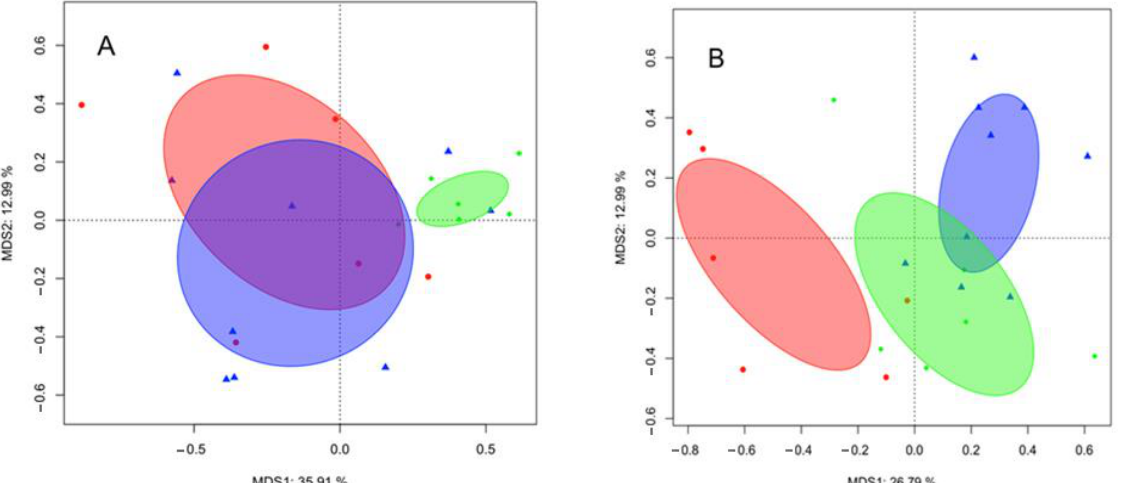
Figure 2. Results of Principal Co-ordinate Analysis (PCoA) of the contemporary and subfossil Cladocera assemblages of the three sampling sites of the Nagy–Morotva oxbow lake. ( A ) Contemporary Cladocera assemblage, ( B ) Subfossil Cladocera assemblage. The group centroids of the sites are marked with coloured ellipses (Red: Fishing site-1, Blue: Natural site, Green: Fishing site-2). Table 3. Result of pairwise multilevel comparison of subfossil Cladoceran assemblages in the three sites of the oxbow lake using adonis (* represents significance if p adjusted < 0.005). Pairs F.Model R 2 p -Value p adjusted Sig FS-1 vs.